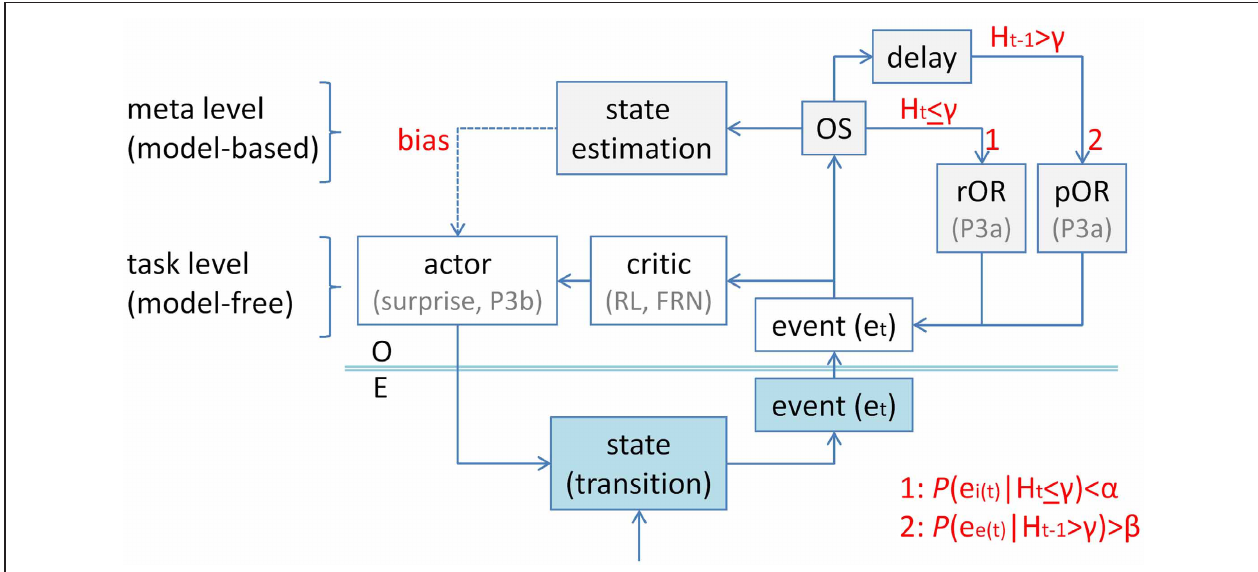
FIGURE 7 | An application of Sokolov’s (1966) entropy model of the orienting response to task switching. An actor-critic architecture (Sutton and Barto, 1998) is assumed at the task level (white frames; with P3b being related to the surprise over switches, FRN being related to negative outcomes). Perception of event e at time t ( e t ) activates processing at the task level, and it initiates processing in the multi-faceted orienting system (OS; light gray frames), which leads under two different conditions to an orienting response (OR): (1) If e t is entropy-inducing ( e i ) and unexpected, i.e., P ( e i ( t ) ) < α (with α → 0), under a non-entropic measure at time t , i.e., H t < γ . (2) If e t is entropy-eliminating ( e e ) and expected, i.e., P ( e e ( t ) ) > β (with β → 1), under an entropic measure at delayed time t -1, i.e., H t − 1 > γ . In case (1), a reactive orienting response (rOR) is evoked, whereas a proactive orienting response (pOR) is released in case (2). Further, the OS serves as a switch from task control at the task level to task control at the meta level. One of the functions of meta-level processing is to estimate the current state of